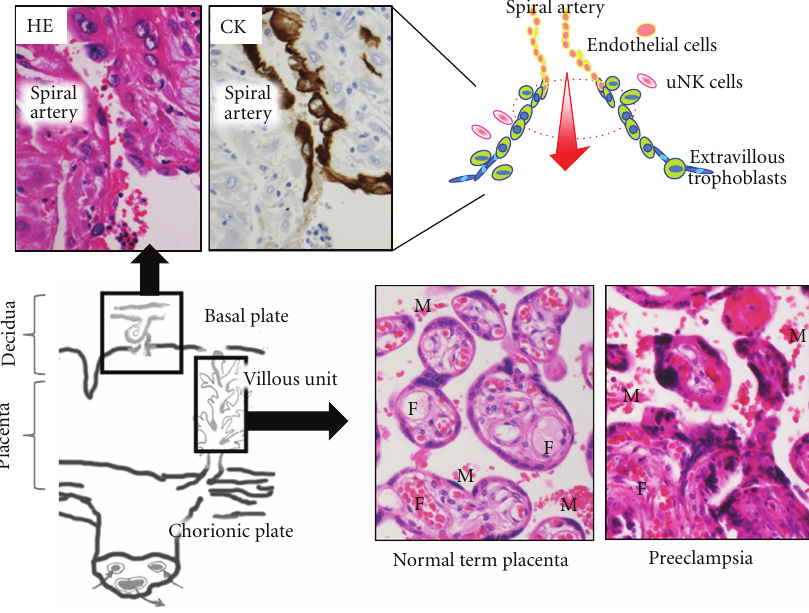
Figure 1: Schema and histology of the placenta. Endothelial cells of spiral arteries are replaced by cytokeratin- (CK-) positive extravillous trophoblasts (upper left). In terminal villous units, two distinct blood pathways exist, that is, maternal blood flow (M) and fetal circulation (F) that are separated by syncytiotrophoblasts. Villi are finely di ff erentiated in normal term placentas, but poorly branched with fibrinous exudate and aggregation of syncytiotrophoblastic nuclei in preeclamptic